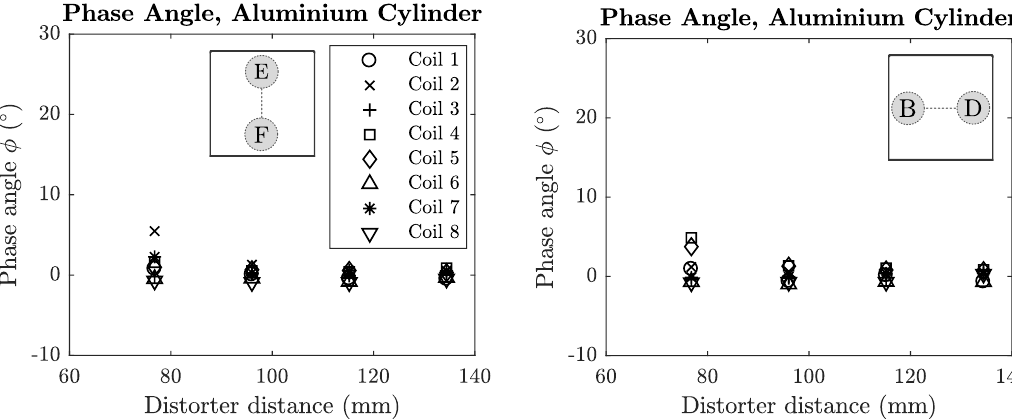
Figure A9. Phase error plots for large aluminium cylinder in locations E to F and B to D. The cylinder spans the length of the transmitter board. The highest phase errors correspond to the positions of the distorter. Positive phase error is experienced in each